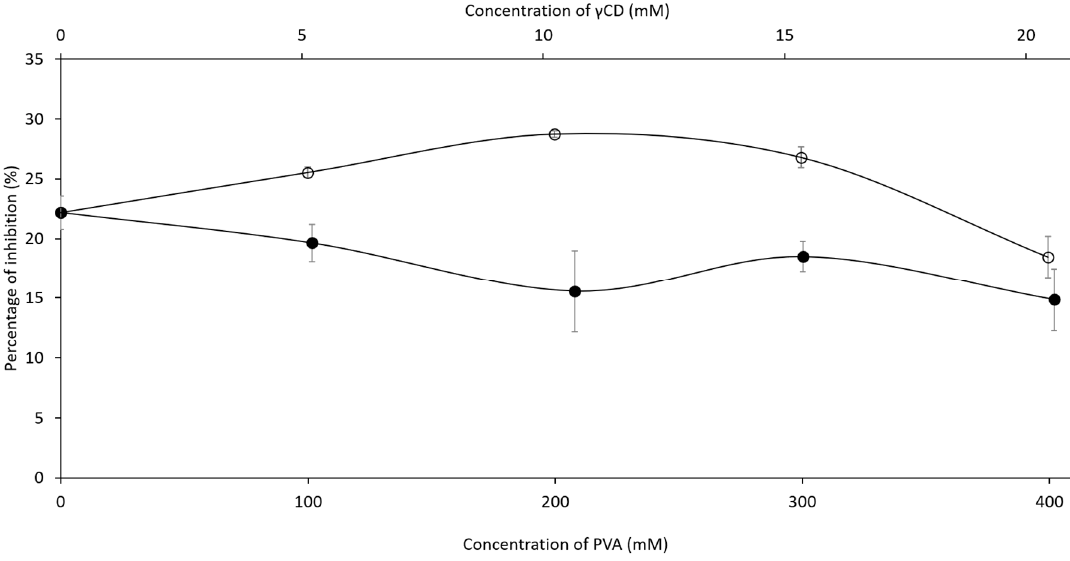
) and AA / PVA ( • ) complexes. (cid:35)